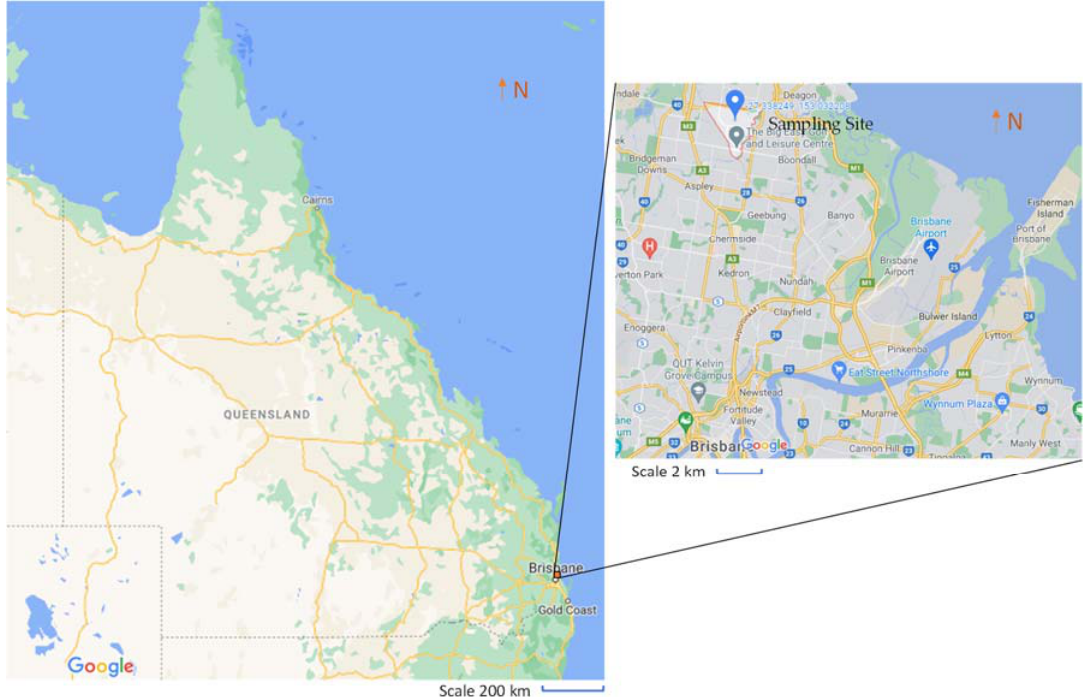
Figure 1. Queensland, Australia map and sampling site (adopted from Google Maps).